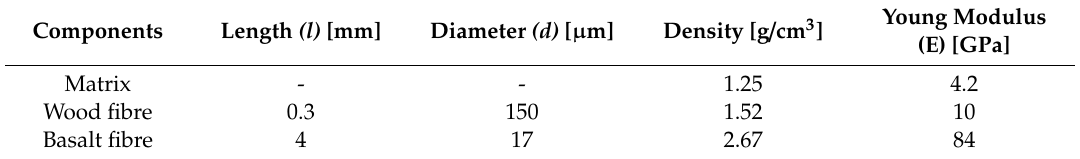
Table 3. Characteristics of components after processing